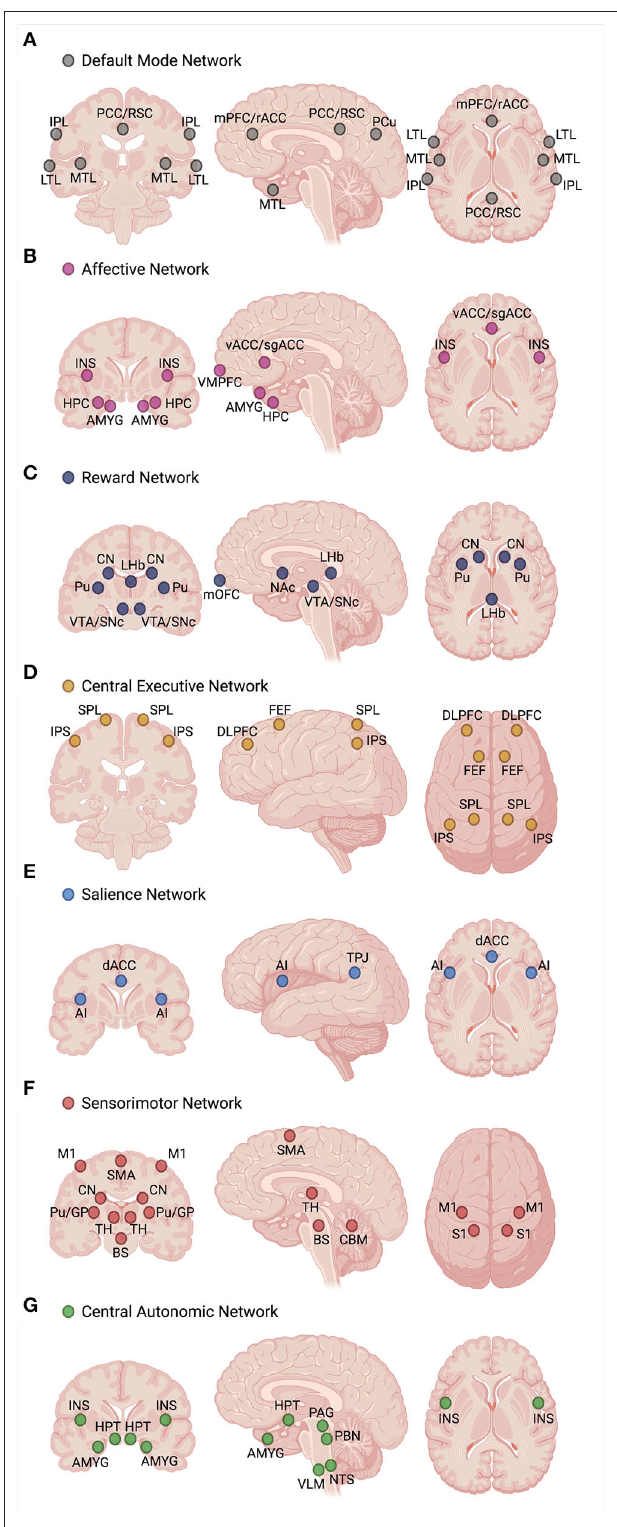
FIGURE 3 | Functional profile of seven intrinsic connectivity networks (ICNs), including the (A) default mode network (DMN), (B) ventromedial affective network (AN), (C) ventral frontostriatal reward network (RN), (D) frontoparietal